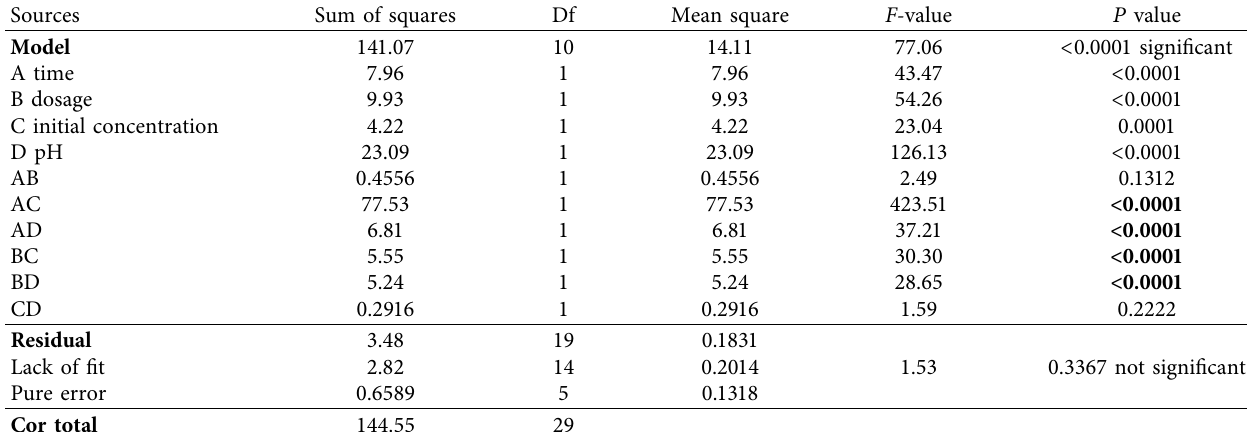
Table 3: ANOVA table for the model to predict % removal.